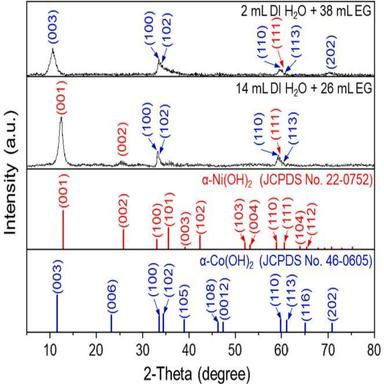
The XRD patterns of CoNi LDHs prepared in a combined solvent of deionized water and ethylene glycol with different volume ratio.